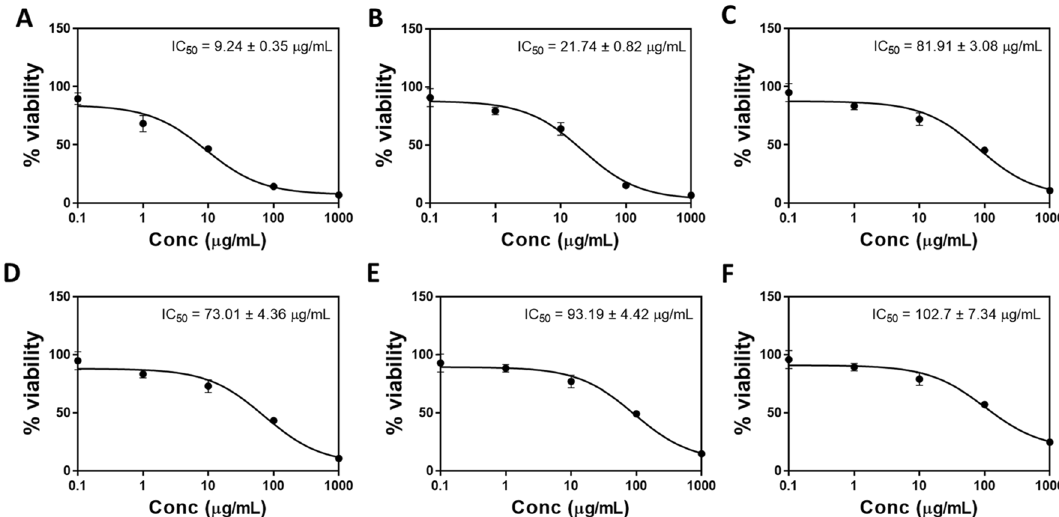
Figure 5. FLV-PL-ALA-MEL ( A , D ), FLV ( B , E ), and Plain formula ( C , F ) IC50 levels in Caco2 and EA.hy926 cells, respectively.